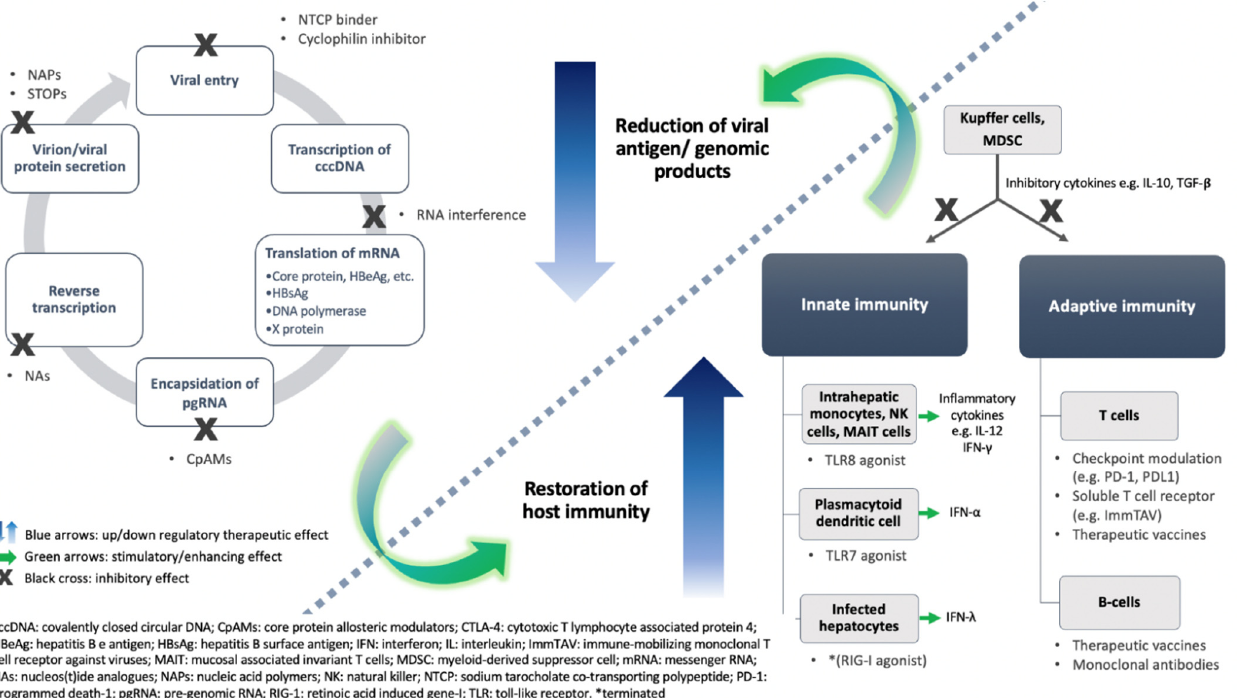
Figure 1. Schematic diagram illustrating the therapeutic approaches currently in clinical development in chronic hepatitis B infection. Left panel: virus-directed agents target different steps of the viral replicatory cycle, including viral entry, RNA interference, capsid formation and pgRNA encapsidation, DNA synthesis, and viral protein secretion. Although NAs are already in clinical use, they will remain the backbone of combination therapy in the context of novel antiviral treatment. Right panel: immune modulatory agents restore the host immunity at both innate and adaptive systems, which are interlinked by inflammatory cytokines and specific cell types. *RIG-I agonists once entered a phase 2 clinical trial but this was terminated due to a safety issue. The two approaches are intercalated as represented by the curved green arrows and the dotted line. Table 2. Novel antiviral agents in clinical phases of